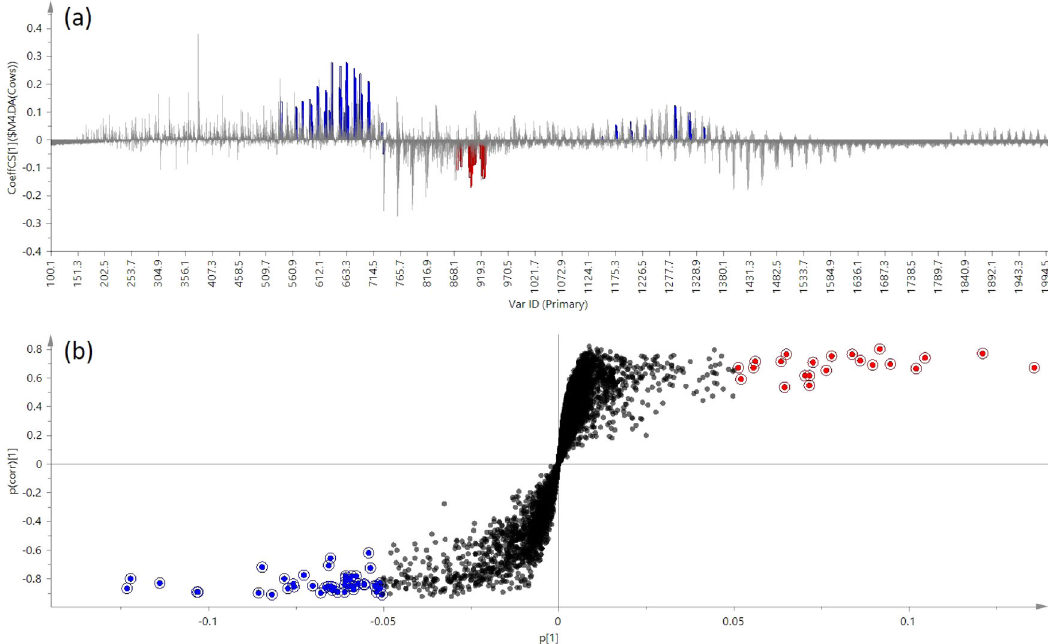
Fig. 6 a Coef fi cients for different milk groups. Cow milk = -1, other milk species = 1; b Candidate biomarkers marked in OPLS-DA/S-plot of ions responsible for the cow milk classi fi cation found at the bottom of the plot, whereas ions responsible for dairy-free samples were located at the top.